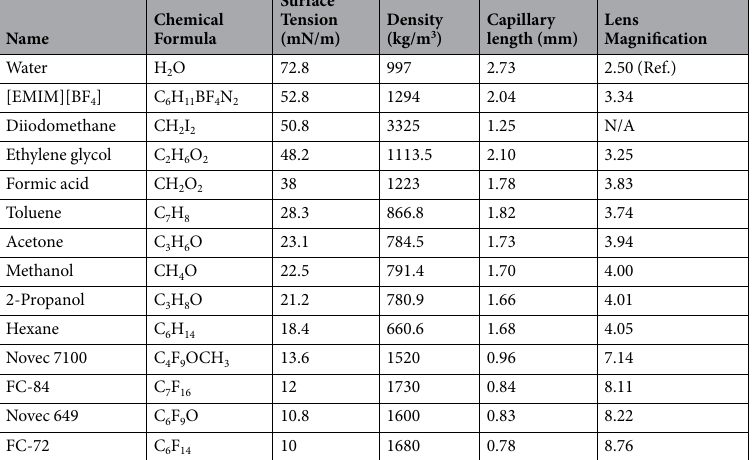
Table 1. Properties of the test liquids with their capillary length and magnification used for an accurate contact angles measurement. Diiodomethane is also included as a comparison 12